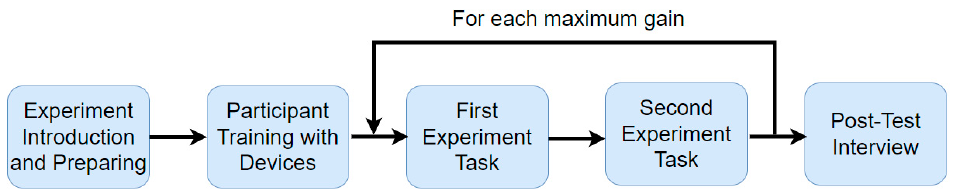
Figure 3. Experiment procedure for each participant.